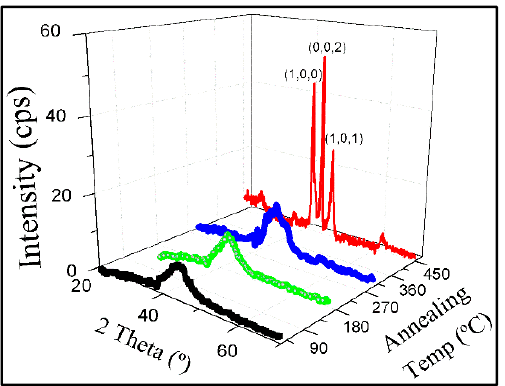
Figure 3. X-ray diffraction patterns of the obliquely as-deposited Co film (black), as well as annealed at 180 °C (green), 315 °C (blue) and 450 °C (red, in the coloured version). The indexes correspond to hcp Co.